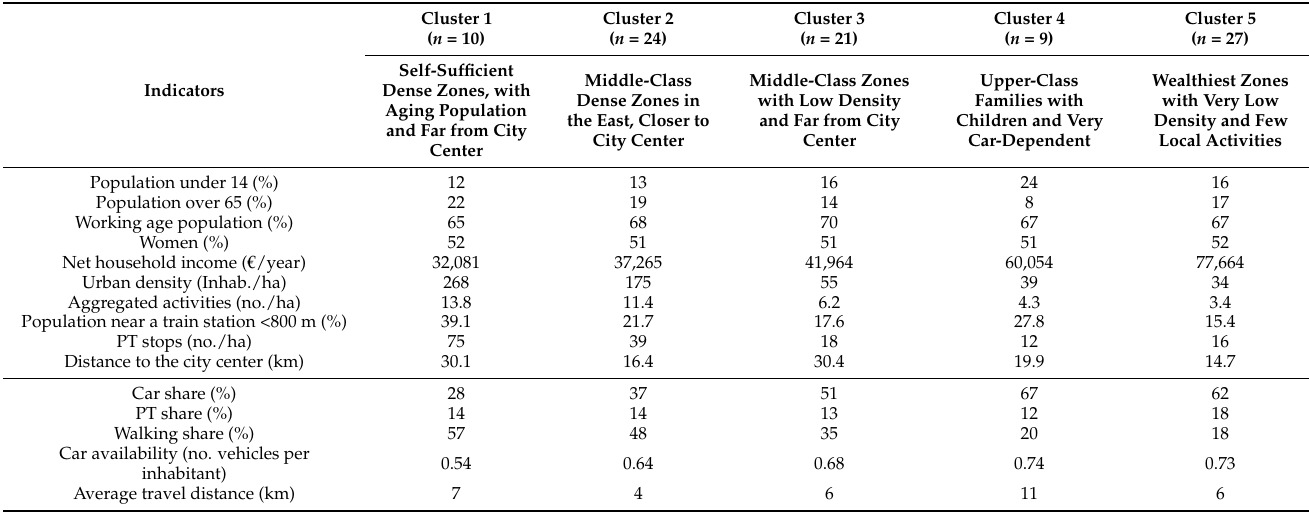
Table 6. Average profile of transport zones in each cluster (See Figure A1).